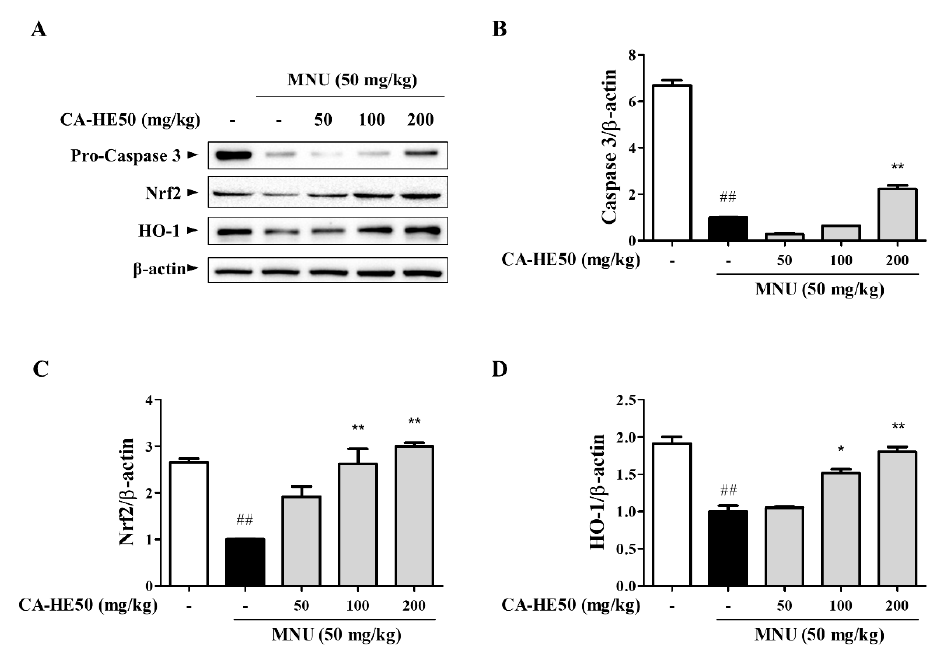
Figure 2. Protein expression from five groups of mice 24 h post-injection of MNU. ( A ) Images of Western blot analysis for expression of proteins associated with retinal damage with MNU. CA-HE50 efficacy results on: ( B ) pro-caspase-3 protein expression; ( C ) Nrf2 protein expression; and ( D ) HO-1 protein expression. ## p < 0.01 vs. normal control group. * p < 0.05 and ** p < 0.01 vs. MNU-treated group. Abbreviations: MNU, N -methyl- N -nitrosourea; Nrf2, nuclear factor erythroid 2; HO-1, heme oxygenase-1.